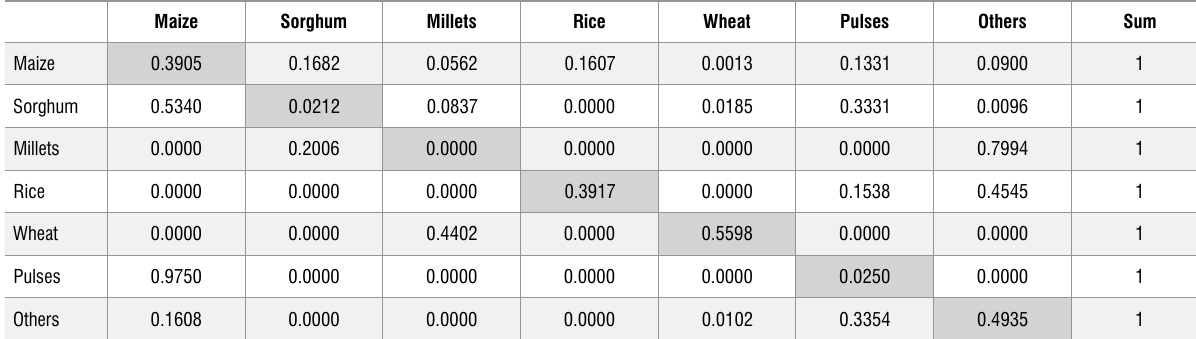
Production Productivity Data source: Tanzanian Ministry of Agriculture 24 Transitional probability matrix for the shift in cropping pattern of major food crops of Tanzania during 2009/2010–2018/2019 Maize Sorghum Millets Maize